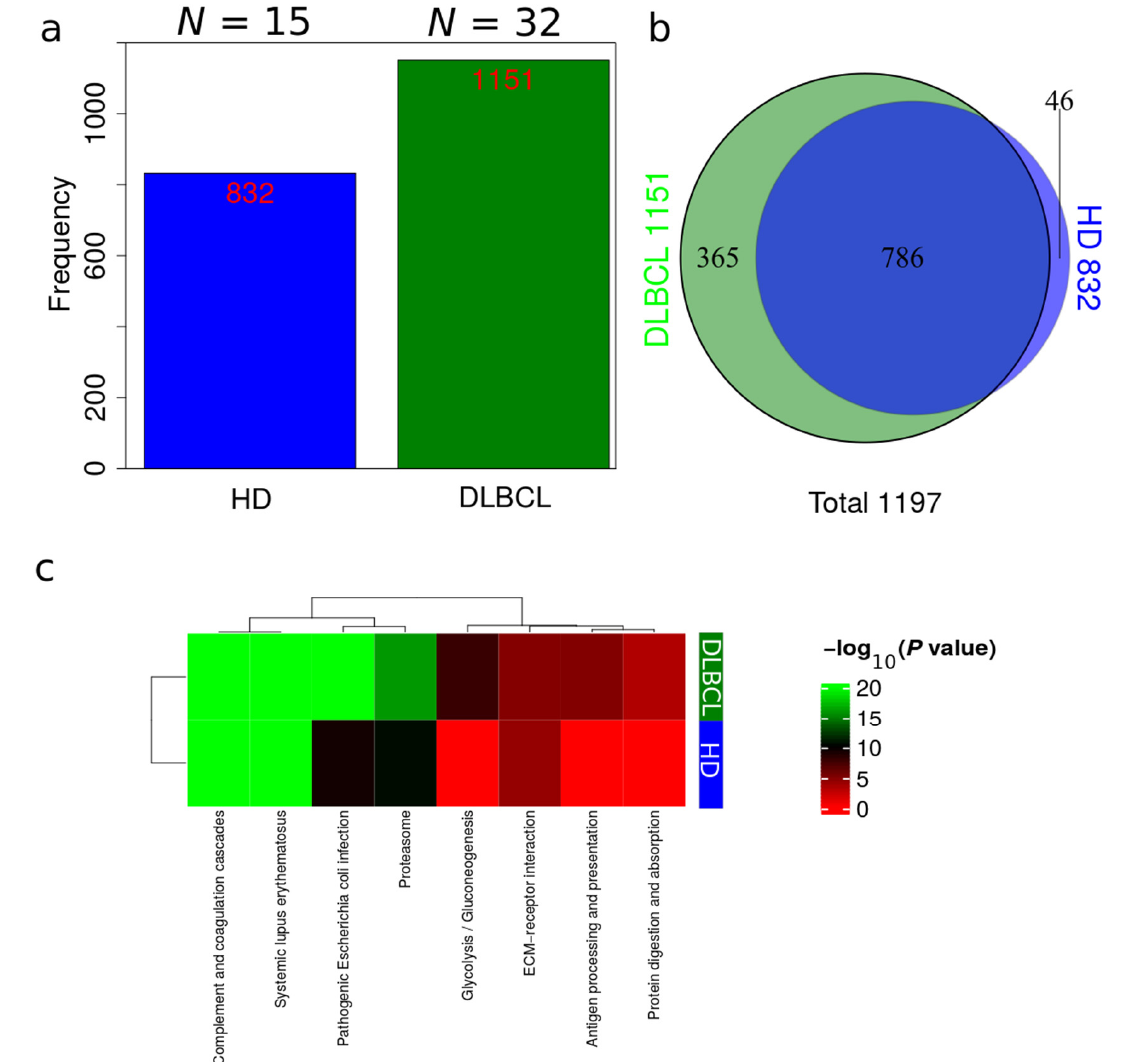
Figure 3. Overview of identifications in DLBCL patients and HDs. ( a ) Total number of identifications from DLBCL patients and HDs. ( b ) Venn diagram comparing identifications in DLBCL patients and HDs. ( c ) Summary of functional KEGG pathway analysis that are either enriched in HDs or DLBCL patients based on all identified proteins from DLBCL and HD groups.